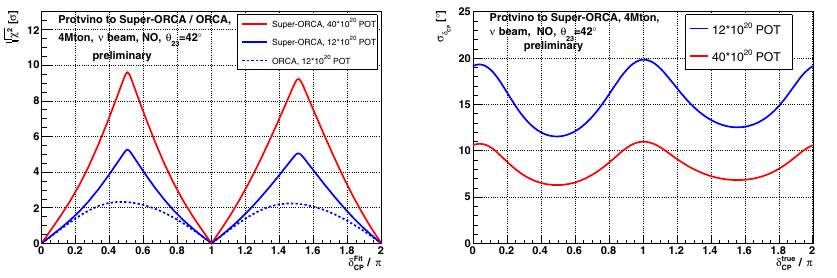
Figure 4. Left: Sensitivities to detect CP violation by operating ORCA 3 years (dashed), Super-ORCA 3 years (solid, blue) and Super-ORCA 10 years (solid-red) in a 450 kW beam from Protvino. Right : Expected 1- σ measurement precision of the CP phase for 3 years (blue) and 10 years (red) data taking with Super-ORCA. (see [10] and [11] for